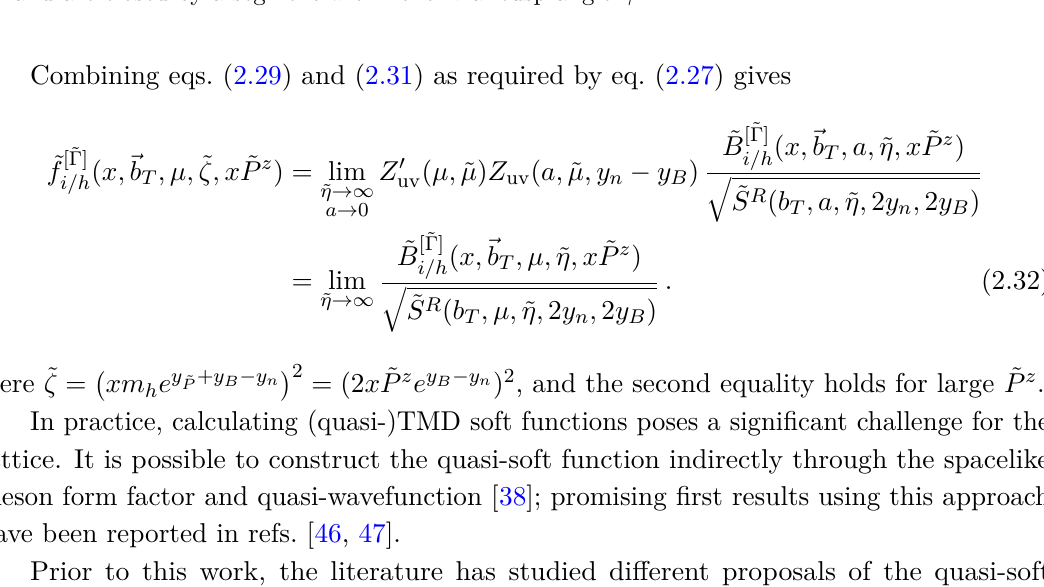
Figure 4 . Wilson line structure of (left) the quasi-beam function in eq. (2.29), and (right) the MHENS scheme in eq. (2.39). Quasi-TMD staple legs extend along the z direction and are closed by a perpendicular segment, whereas MHENS staple legs extend along a generic spacelike direction v µ and are closed by a segment with nontrivial cusp angle γ